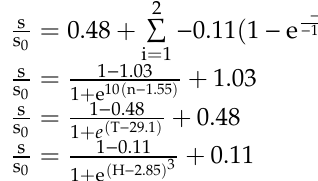
Table 8. Maximum interfacial shear stress and slip.